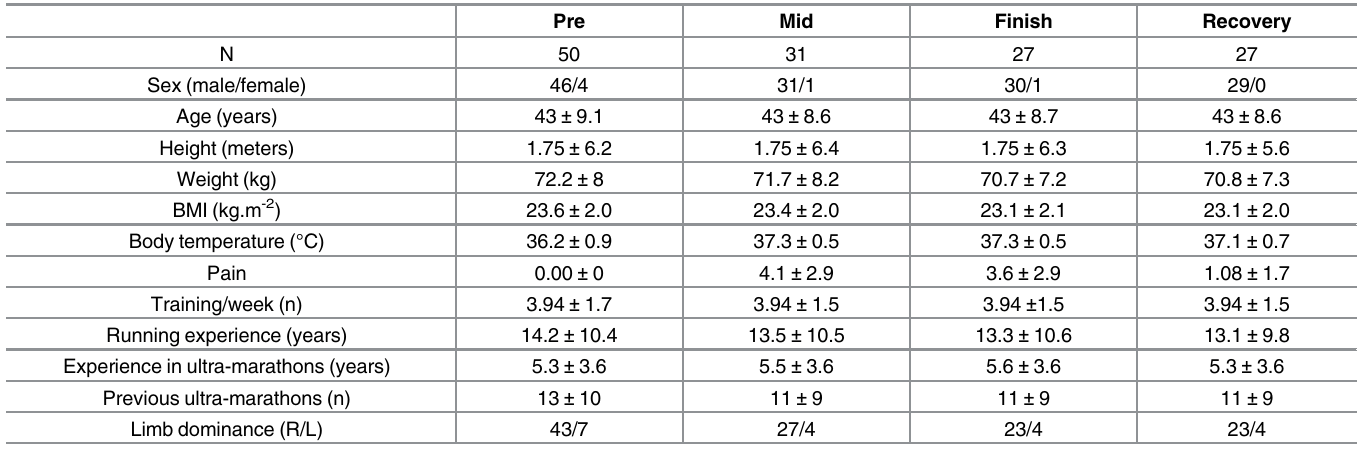
Table 1. Demographic and training profile